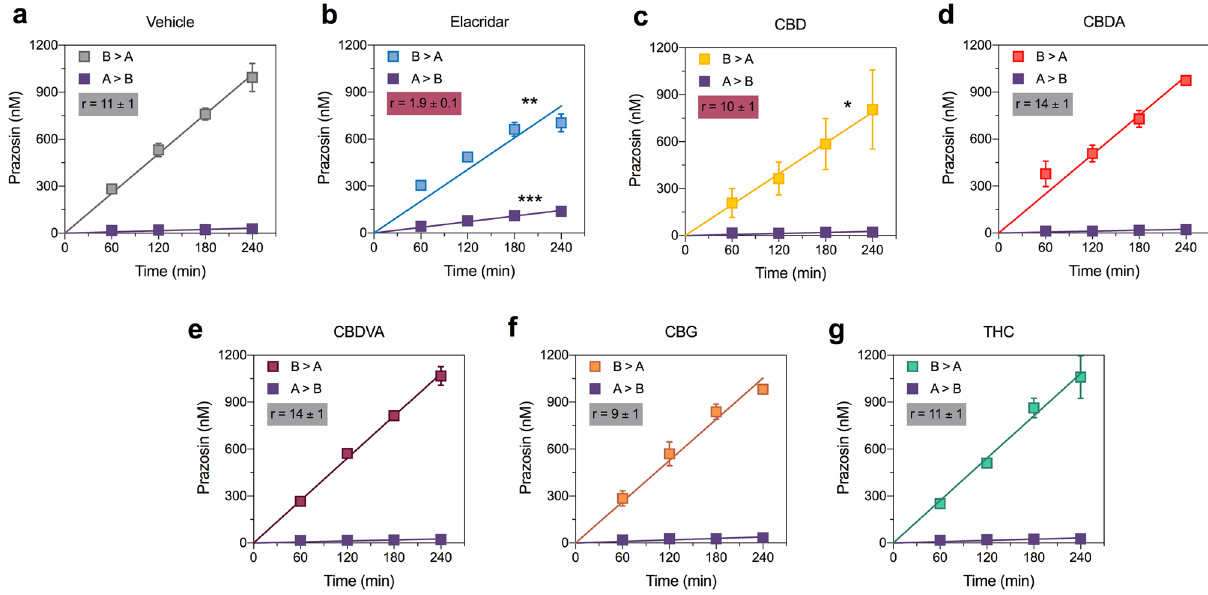
Figure 4. CBD inhibits BCRP-mediated transport. Concentration–time curves for prazosin in the presence of ( a ) vehicle, ( b ) elacridar, ( c ) CBD ( d ) CBDA, ( e ) CBDVA, ( f ) CBG or ( g ) Δ 9 -THC in the basolateral to apical (B > A) and apical to basolateral (A > B) directions in cells expressing BCRP. Elacridar and CBD significantly inhibit (red shading) transport of prazosin. Data are expressed as means ± SEM, with n = 3–4 per time point. Curves represent fits to a linear regression and transport efflux ratios (r) are listed (* p < 0.05, ** p < 0.005, *** p < 0.0005 compared to vehicle; Extra sum-of-squares F test).